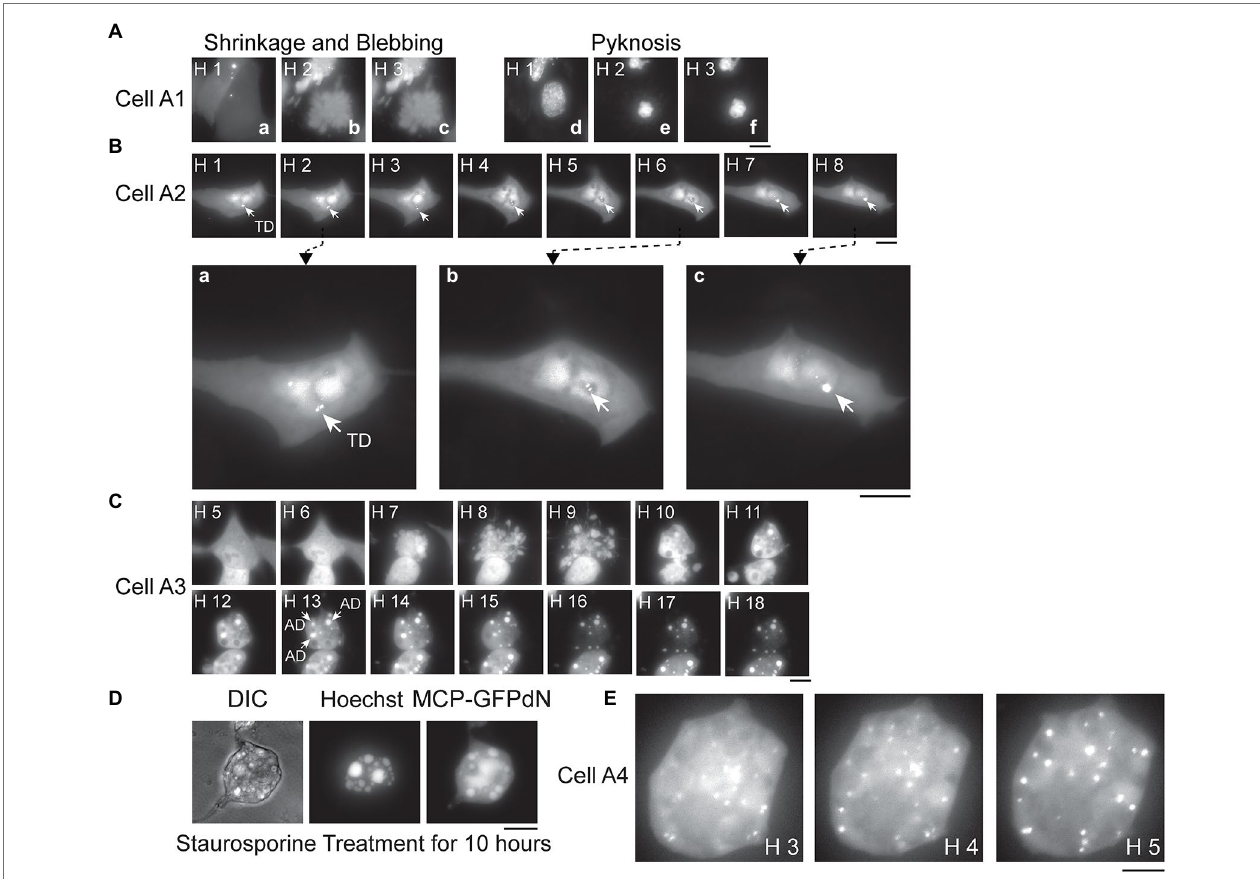
FIGURE 3 | Apoptosis and signals derived from transcribed or replicated PB2-vMSL vRNA. (A) A549(MCP-GFPdN) cells were infected with IAV, and the images of representative Cell A1 were taken from Hour 1 to 3 after IAV infection. Images a–c show the fluorescent signals displayed by Cell A1, and which reveal cell shrinkage and blebbing. Images d–f show pyknosis of the nucleus stained with Hoechst 33342. (B) A549(MCP-GFPdN) cells were transfected with pHH-PB2-vMSL, and at 16 h after transfection, cells were imaged every hour for 8 h, with the images derived from representative Cell A2 shown here. The three images, respectively, taken at (a) Hour 2, (b) Hour 6, and (c) Hour 8 post-infection have been enlarged to facilitate viewing, with arrows indicating transcription dots (TDs) generated by PB2- vMSL vRNA transcribed from pHH-PB2-vMSL. (C) A549(MCP-GFPdN) cells were infected by IAV, and the images of apoptotic dots (ADs; indicated by arrows) from representative Cell A3 were taken hourly for 18 h. Note that not all ADs in the cell are indicated. (D) A549(MCP-GFPdN) cells were treated with staurosporine for 10 h to induce apoptosis, and stained with Hoechst 33342 for 30 min before paraformaldehyde fixation. (E) A549(MCP-GFPdN) cells were transfected with pHH-PB2- vMSL, then infected with IAV at 20 h post-transfection and subsequently imaged. Representative Cell A4 displayed blebbing of the plasma membrane at Hour 2 post-infection, and almost all fluorescent signals in the representative images shown here consist of replicated vRNA dots (RDs). Images were acquired using a Nikon TiE eclipse inverted microscope, and images at the indicated time points are displayed as the square of maximum intensity projections across the z-planes in ImageJ. Scale bar: 10 μ